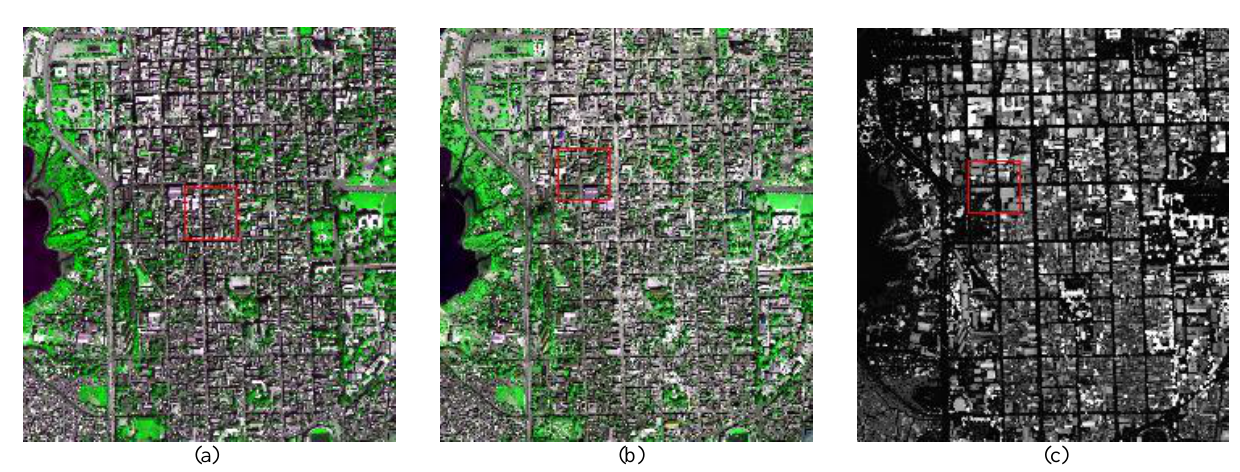
Figure 4. (a) Pre- and (b) post event pan-sharpened multispectral VHR images of the study area. The image size is 3,100 × 2,800 pixel of 0.5 × 0.5m each. (c) post event nDSM of study area